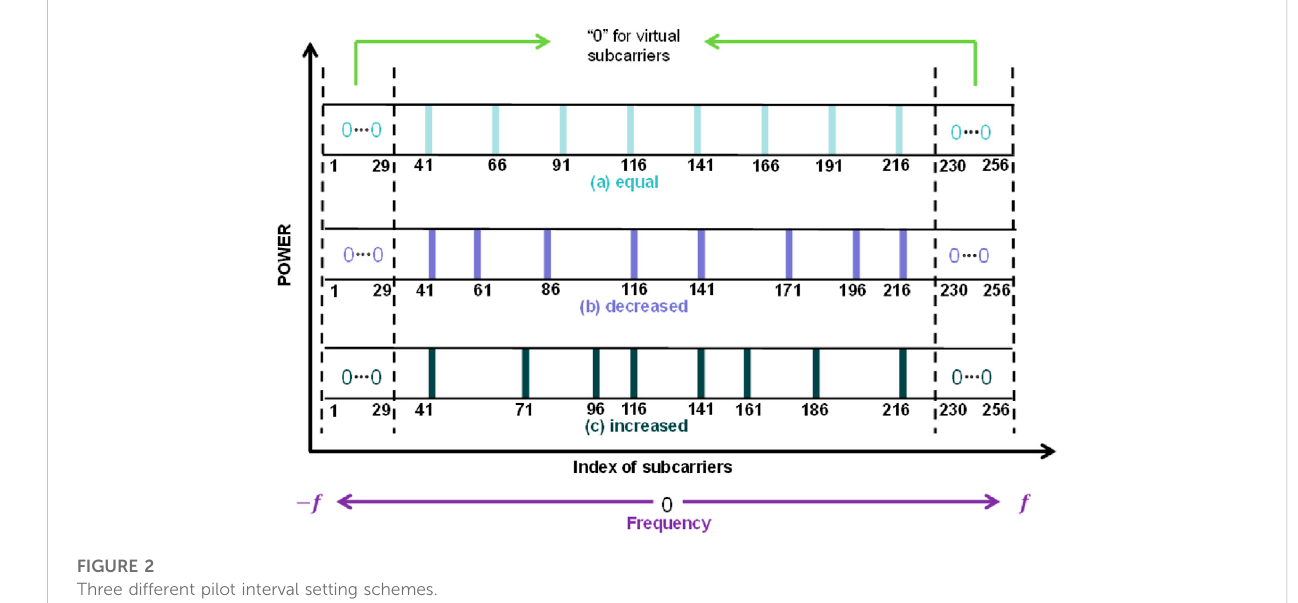
FIGURE 2 Three different pilot interval setting